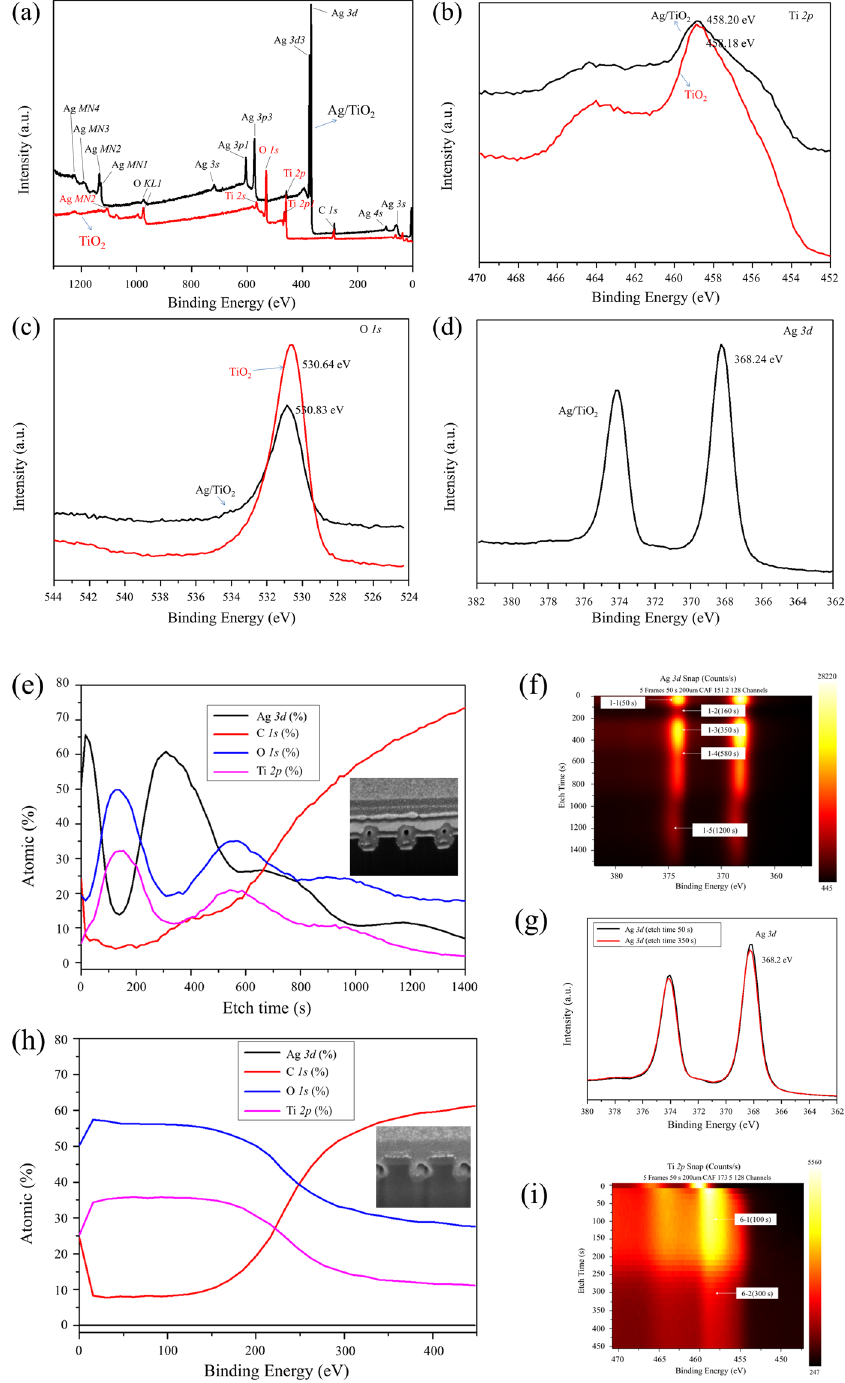
Figure 5. XPS spectra of two-layer Ag/TiO 2 nanocomposite cross architecture and TiO 2 nanowires: ( a ) survey spectra, ( b ) high-resolution Ti 2 p spectra, ( c ) high-resolution O 1 s spectra, and ( d ) high-resolution Ag 3 d spectrum of two-layer Ag/TiO 2 nanocomposite cross architecture. ( e ) Atomic composition of two-layer Ag/ TiO 2 nanocomposite cross architecture depending on etching time. ( f ) Depth profile images of Ag and TiO 2 . ( g ) High-resolution Ag 3d spectra after etching for 50 s and 350 s. ( h ) Atomic composition of TiO 2 nanowire depending on etching time. ( i ) Depth profile image of TiO 2